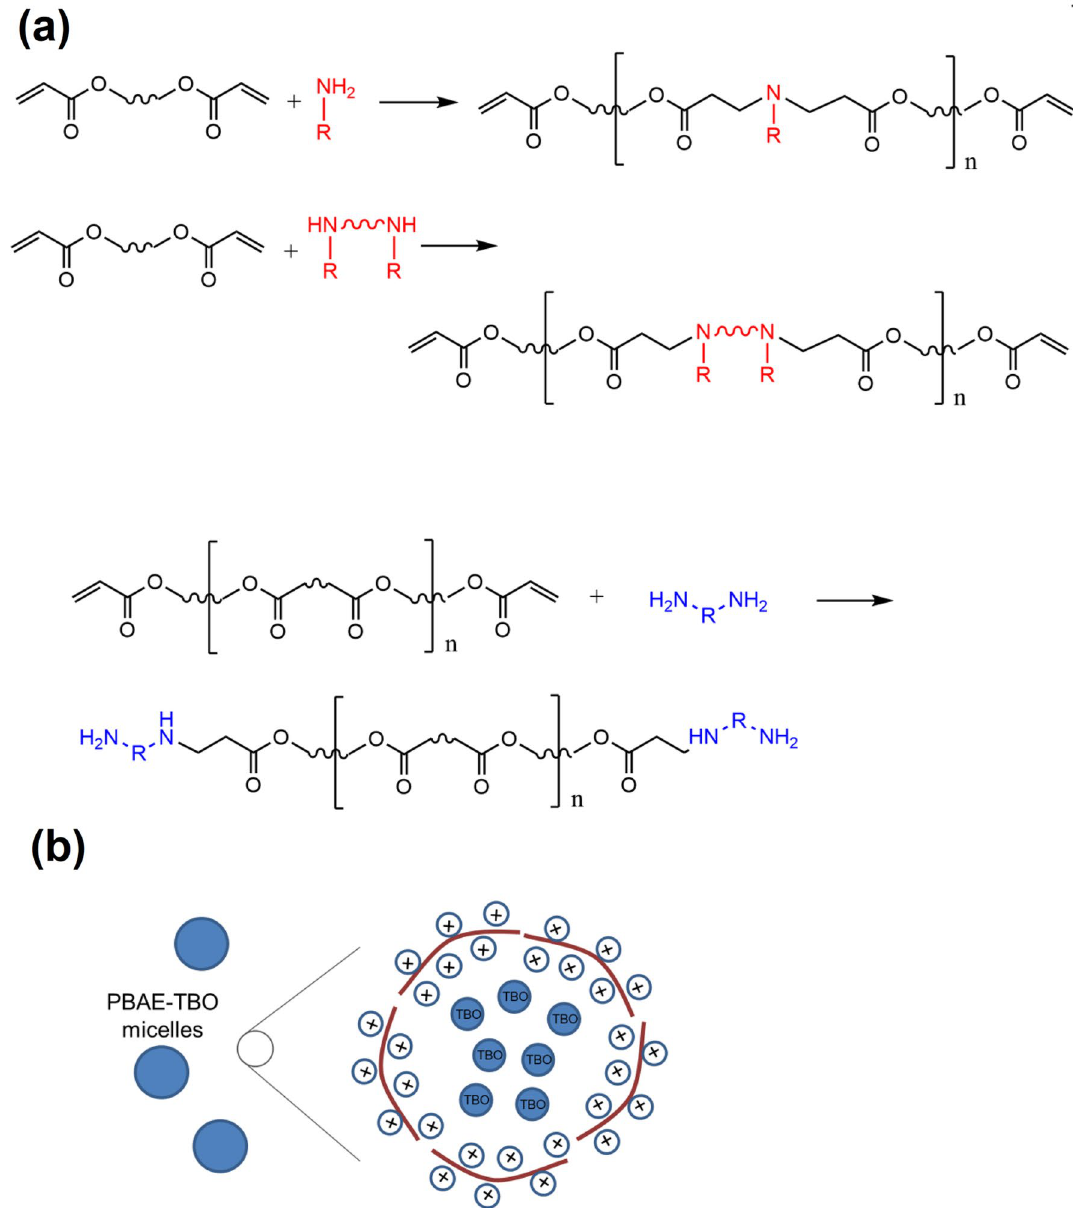
Figure 3. ( a ) PBAE structure and synthesis ( b ) PBAE-TBO